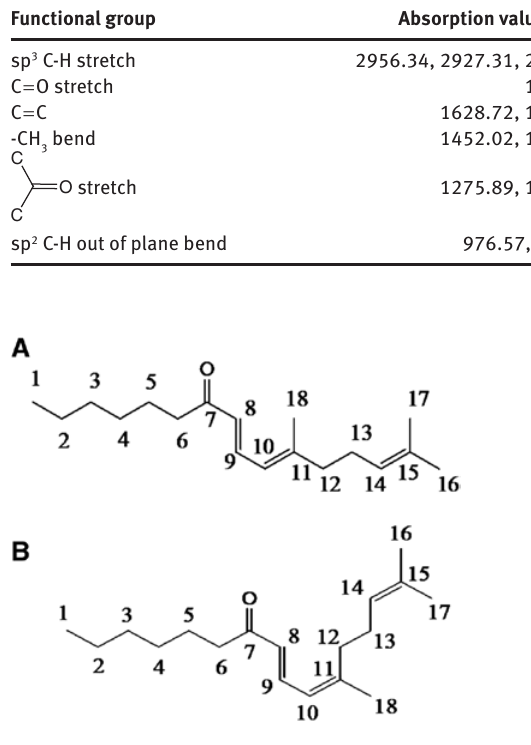
Figure 6: Expected structures.